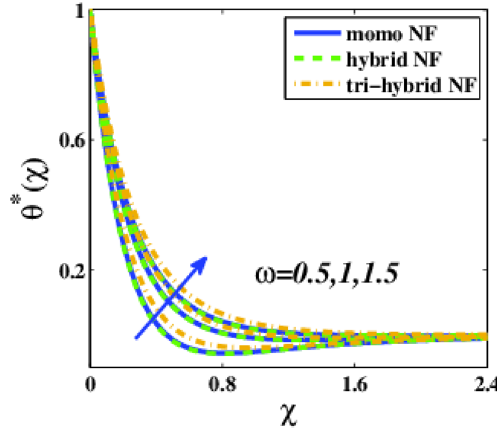
Figure 14. Stimulus of ω on θ ∗ (χ) .